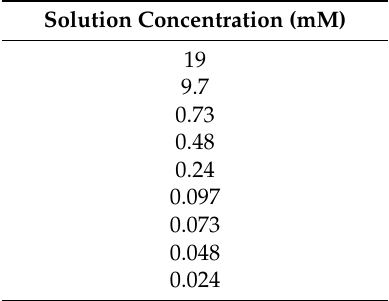
Table 4. Solution concentrations (mM) in both DCM and